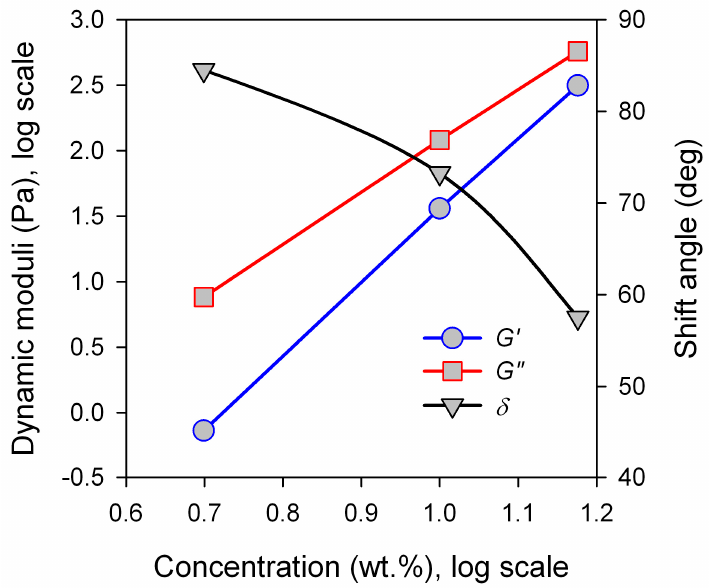
Figure 3. Concentration dependences of the dynamic moduli and shift angle at 1 Hz frequency and shear stress 1 Pa.